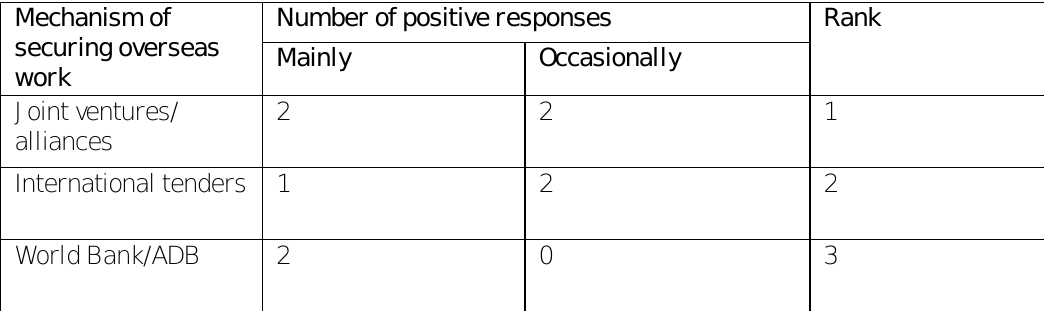
Table 6: Mechanism of securing contracts